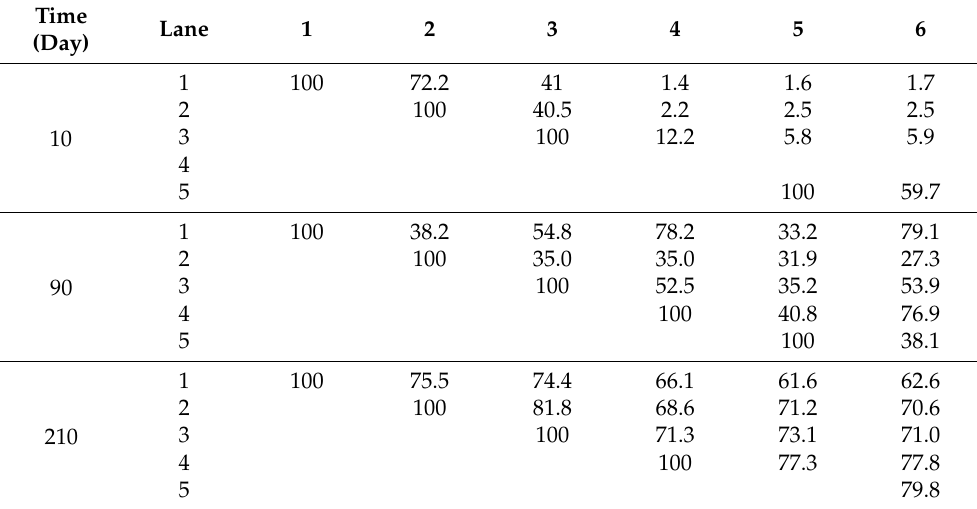
Table 2. Calculation method dice coefficient of similarity matrix on 10 d, 90 d and 210 d